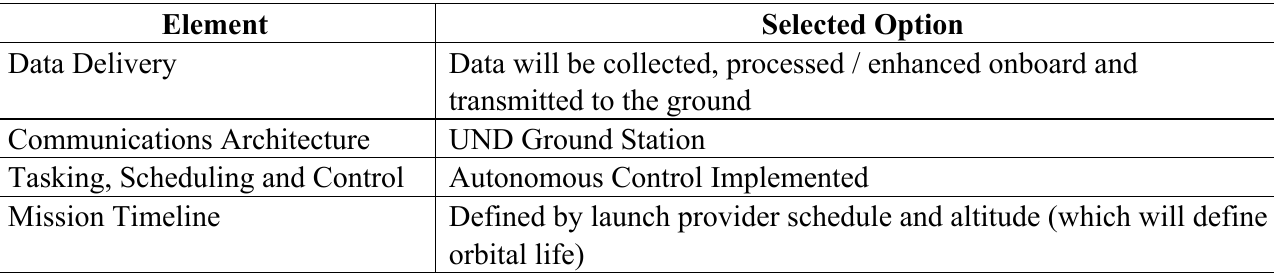
Table 2. Mission Concept of